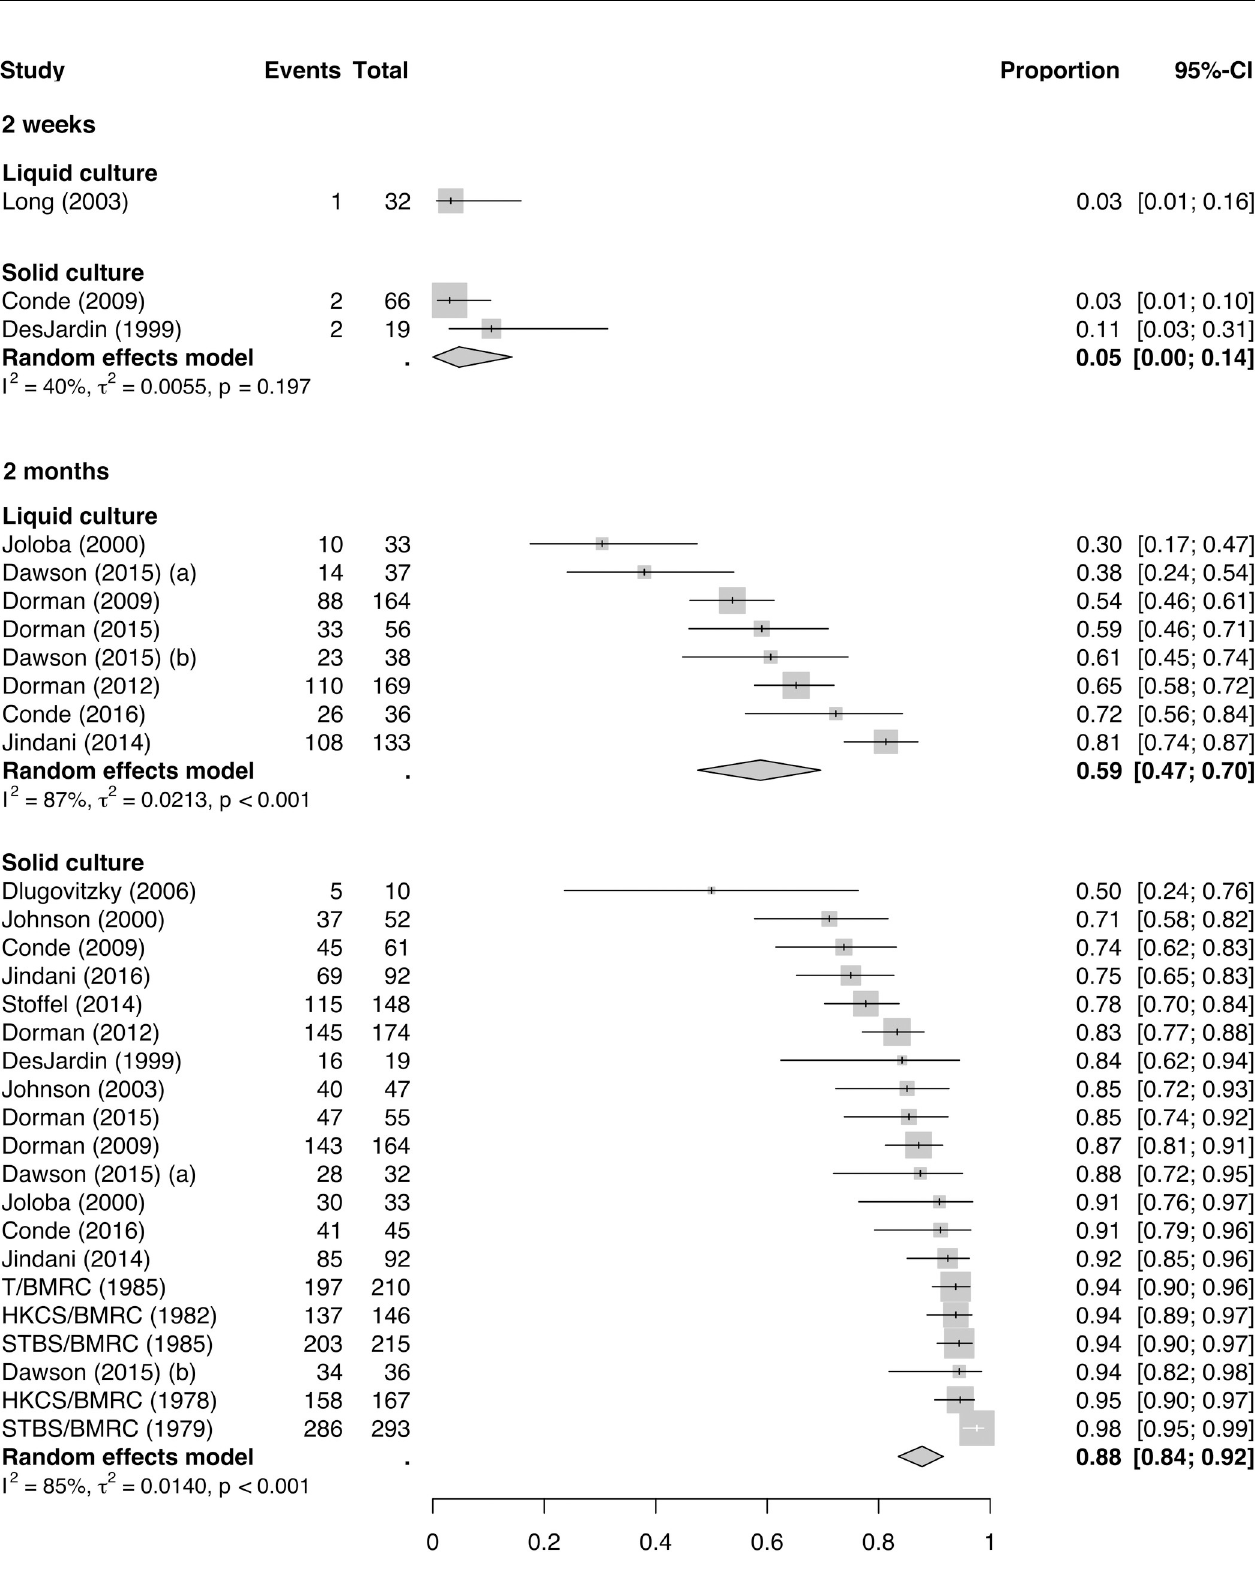
PLOS Medicine| https://doi.org/10.1371/journal.pmed.1003566 April 26, 2021 16 /